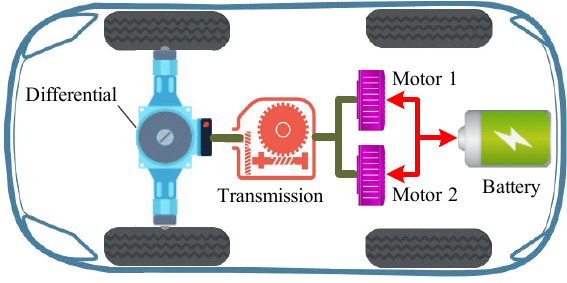
Figure 1. The central dive motor transmission of an electric vehicle (EV). In 1996, Schimidt [13] improved a transmission having two planetary gear trains (PGT). Both the Sun gears and Ring gears of each PGT are connected together. The output shaft is operatively